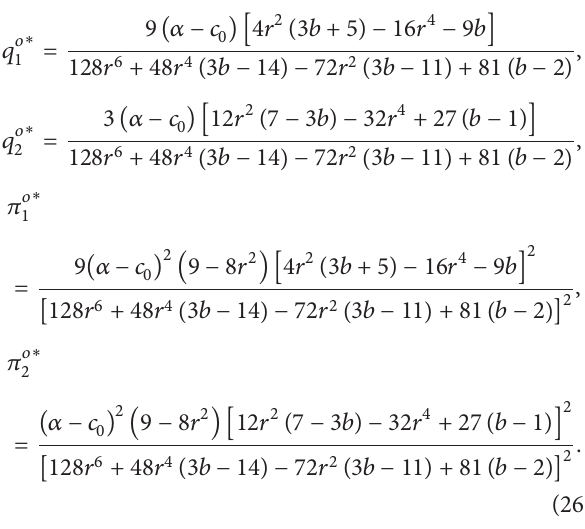
Figure 1: Equilibrium social welfares.